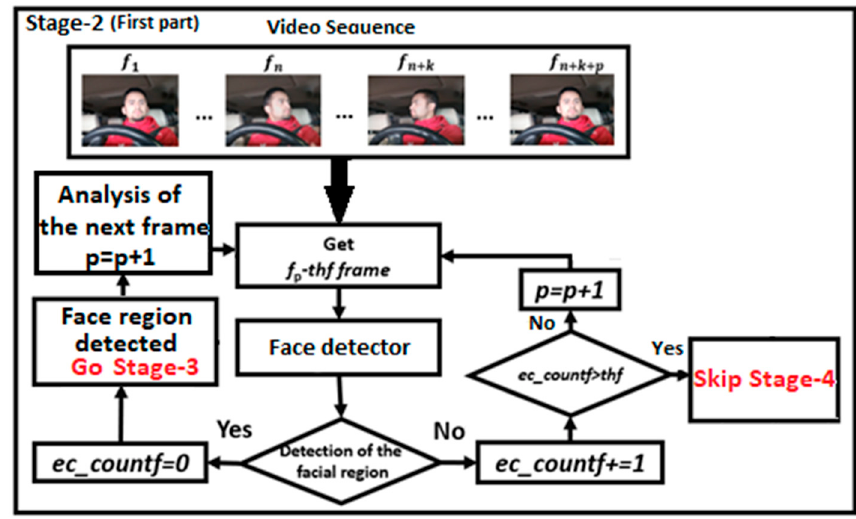
Figure 3. Analysis of consecutive results (First part of Stage 3).